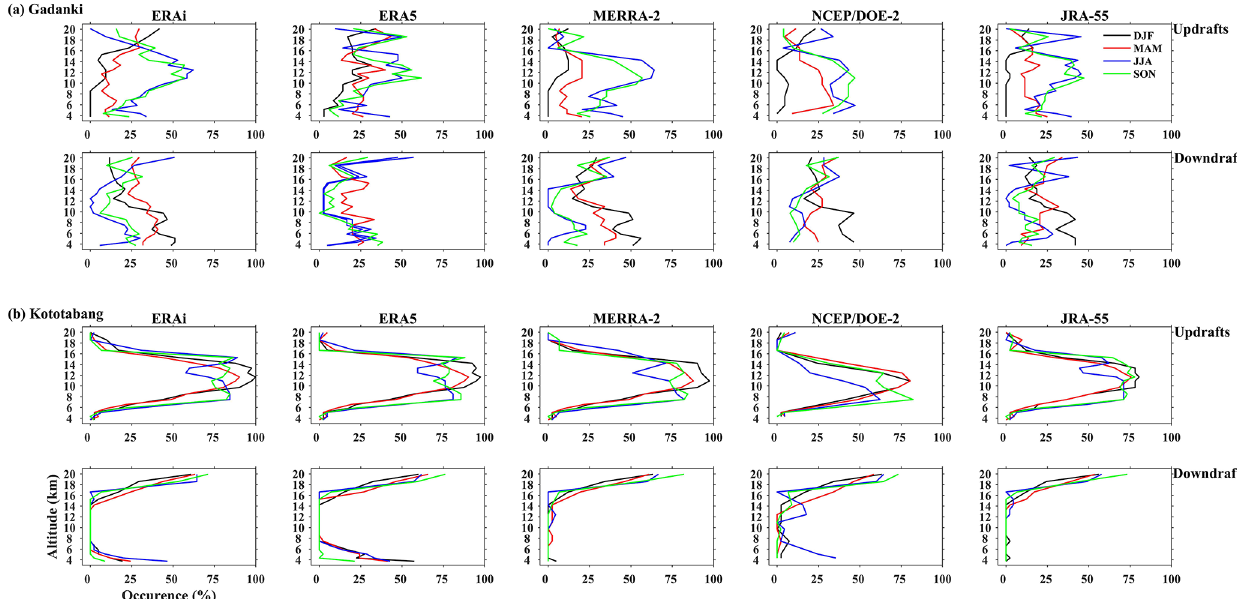
Figure 13. Comparison of directional tendency of w between the radars and various reanalysis datasets for (a) Gadanki (1995–2015) and (b) Kototabang (2001–2015). Updrafts are shown in rows 1 and 3, and downdrafts are shown in rows 2 and 4 (for details see